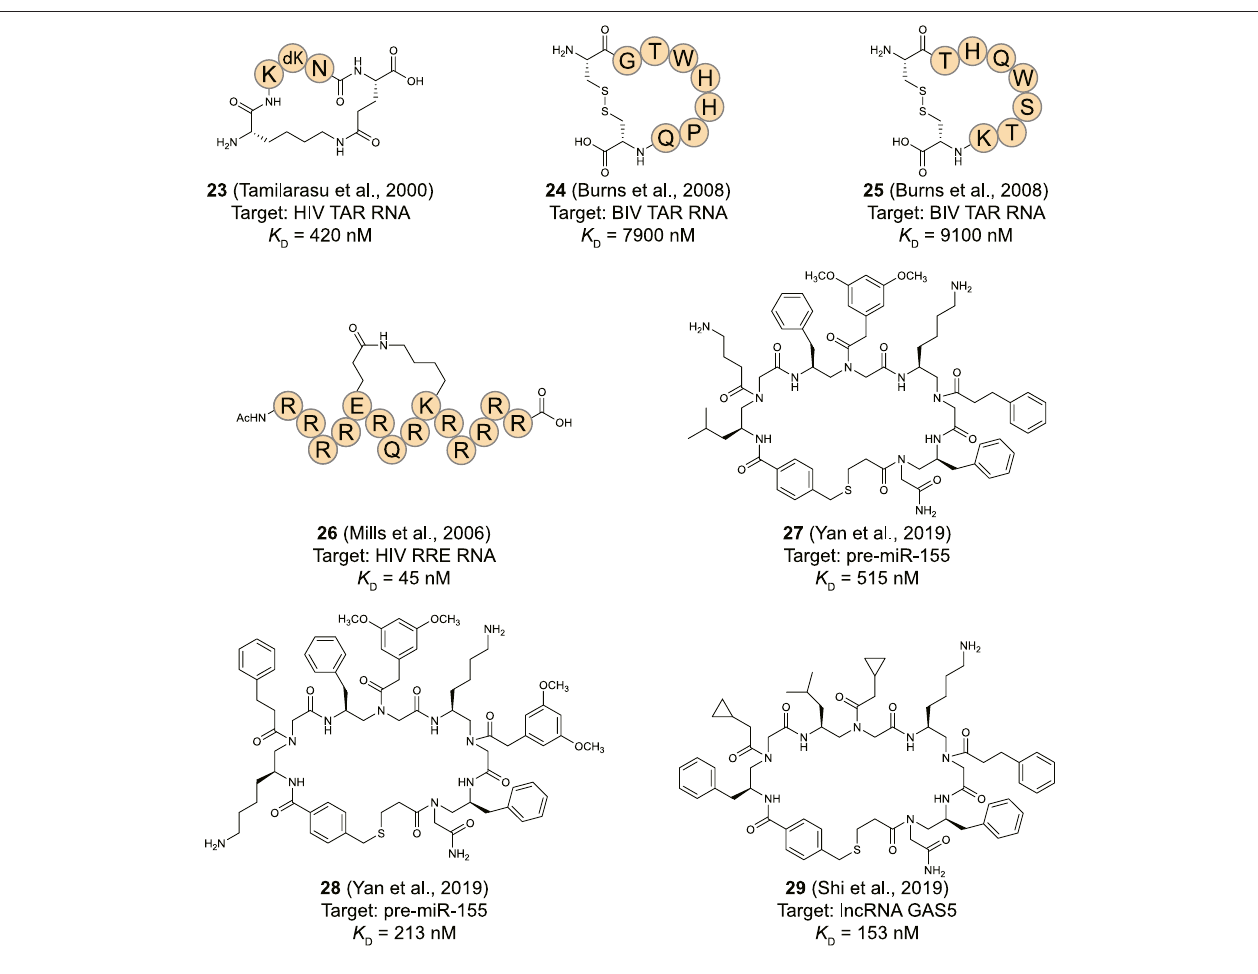
FIGURE 11 | Structures of RNA-binding cyclic peptides identi fi ed via library